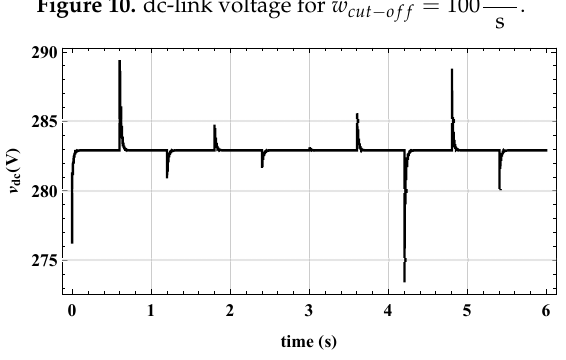
Figure 10. dc-link voltage for w cut − of f = 100